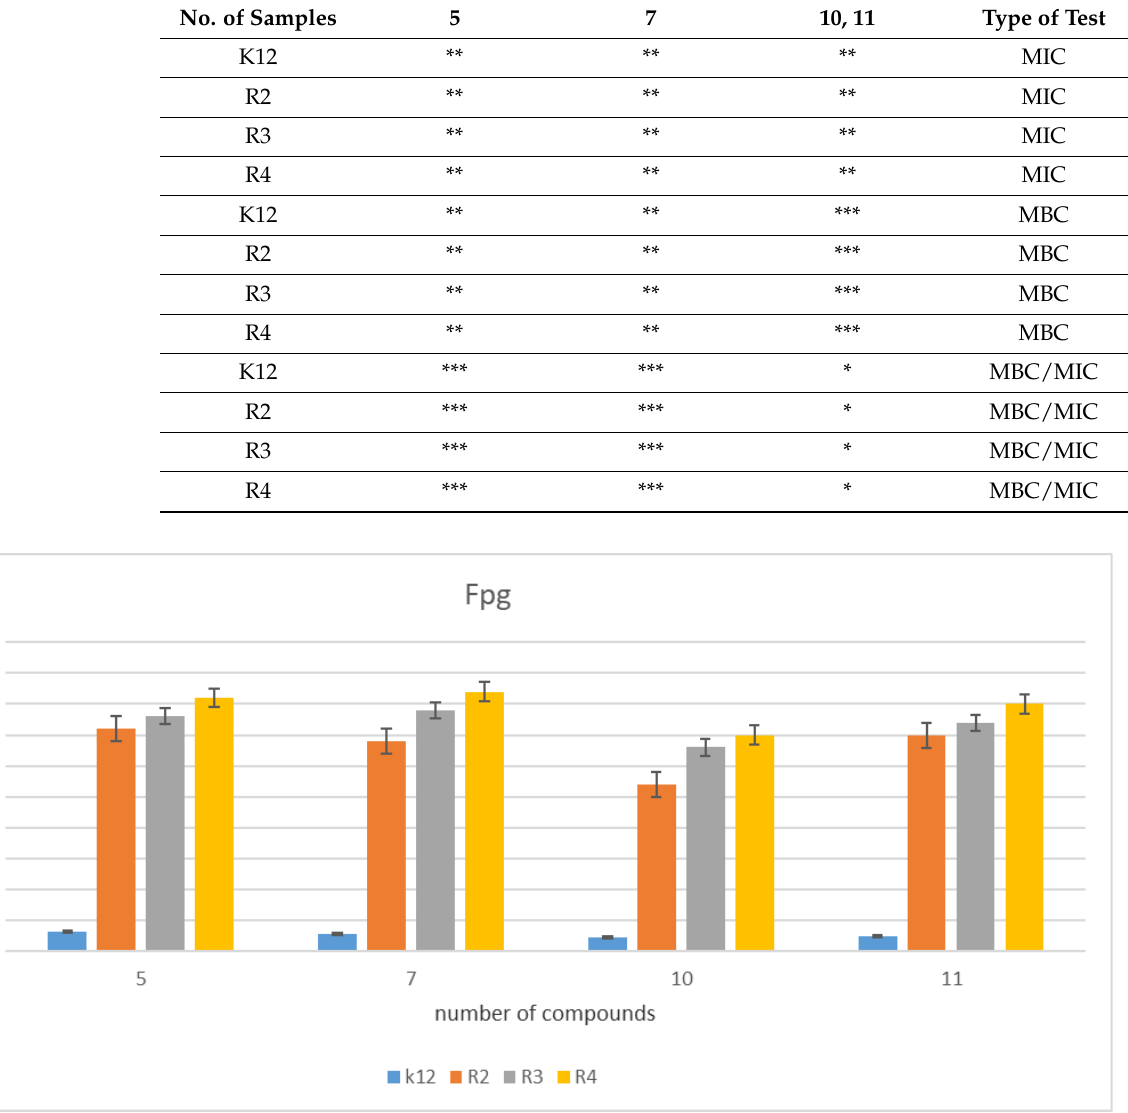
Table 2. Statistical analysis of all analyzed compounds by MIC, MBC, and MBC/MIC; <0.05 *, <0.01 **, <0.001 ***.